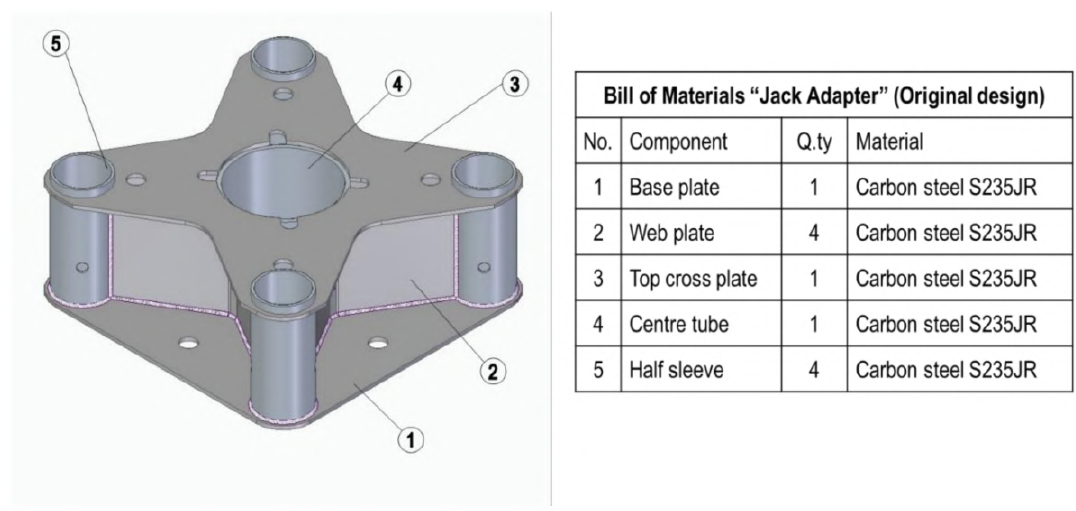
Figure 6. Heavy-duty prop product and application.